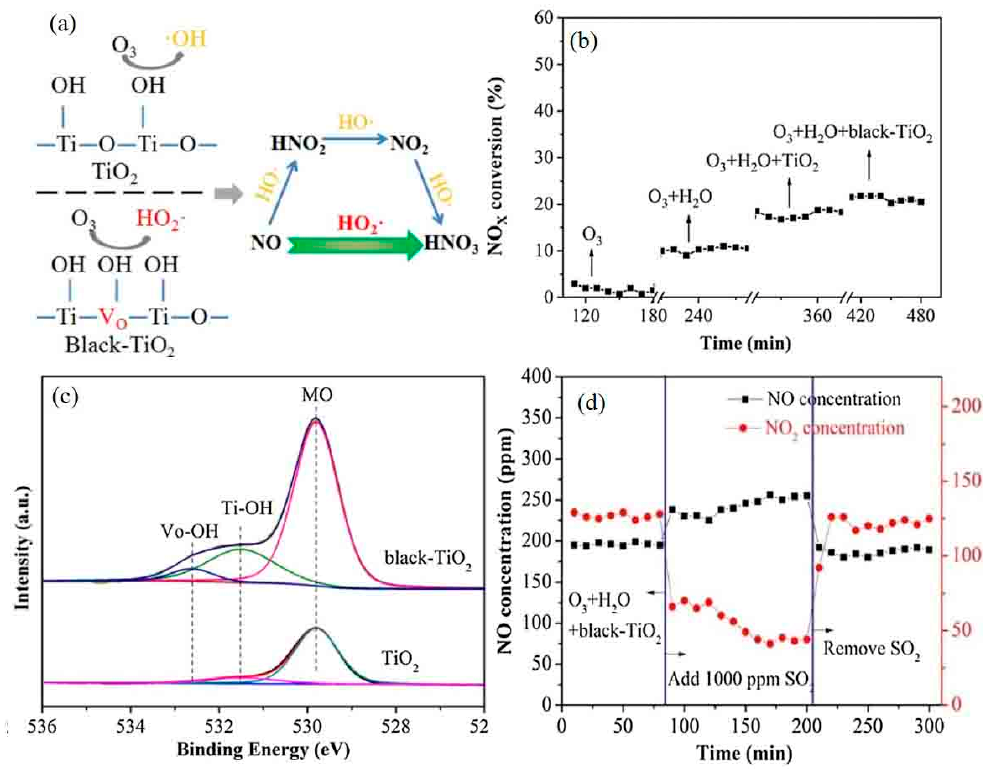
Figure 3. ( a ) Reaction mechanism of NO x removal by O 3 in black TiO 2 , ( b ) de-NO x performance at 60 °C, ( c ) X-ray photoelectron spectroscopy (XPS) analysis under different conditions, and ( d ) sulfur resistance of black TiO 2 under 1000 ppm SO 2 [88]. Reproduced from Ref. [88], Copyright 2018,